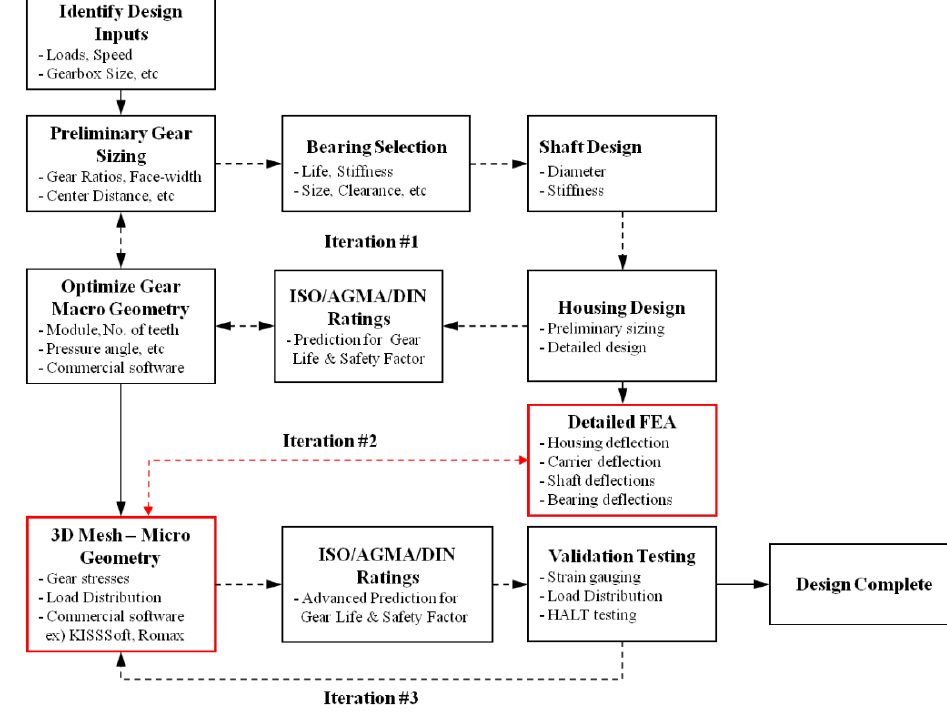
Figure 2. Typical gearbox design procedure (Radzevich, 1951).